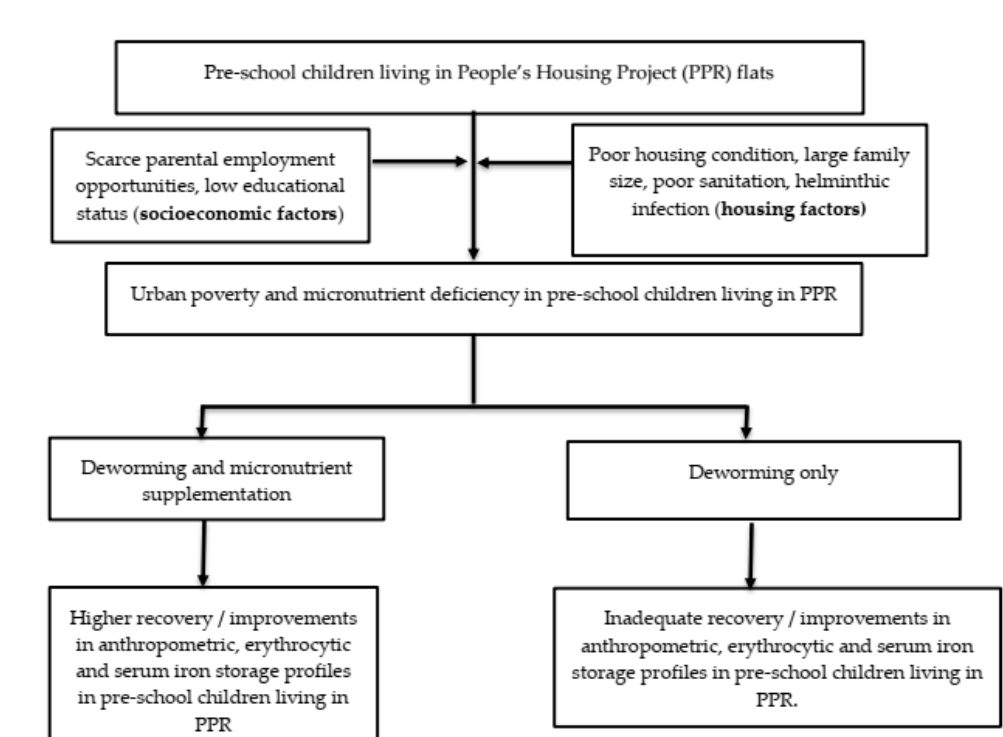
Figure 1. The conceptual framework of the CUPIP trial.